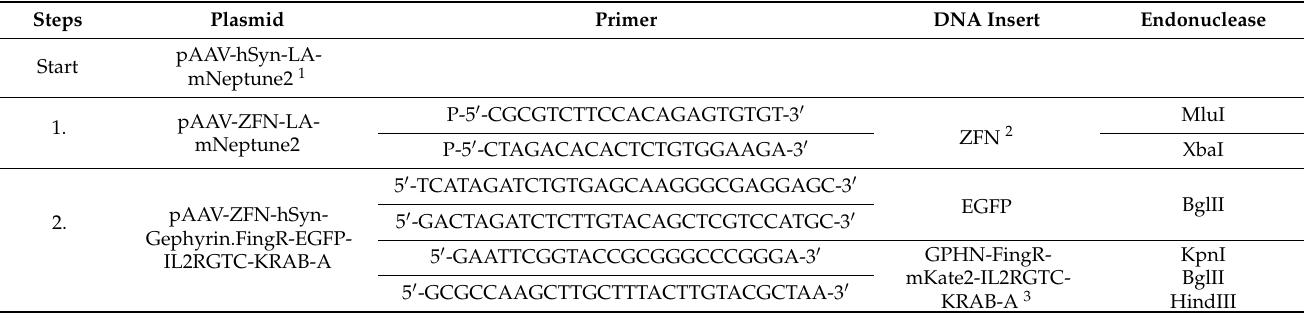
Table 1. The plasmid pAAV-ZFN-hSyn-Gephyrin.FingR-EGFP- IL2RGTC-KRAB-A was cloned in two